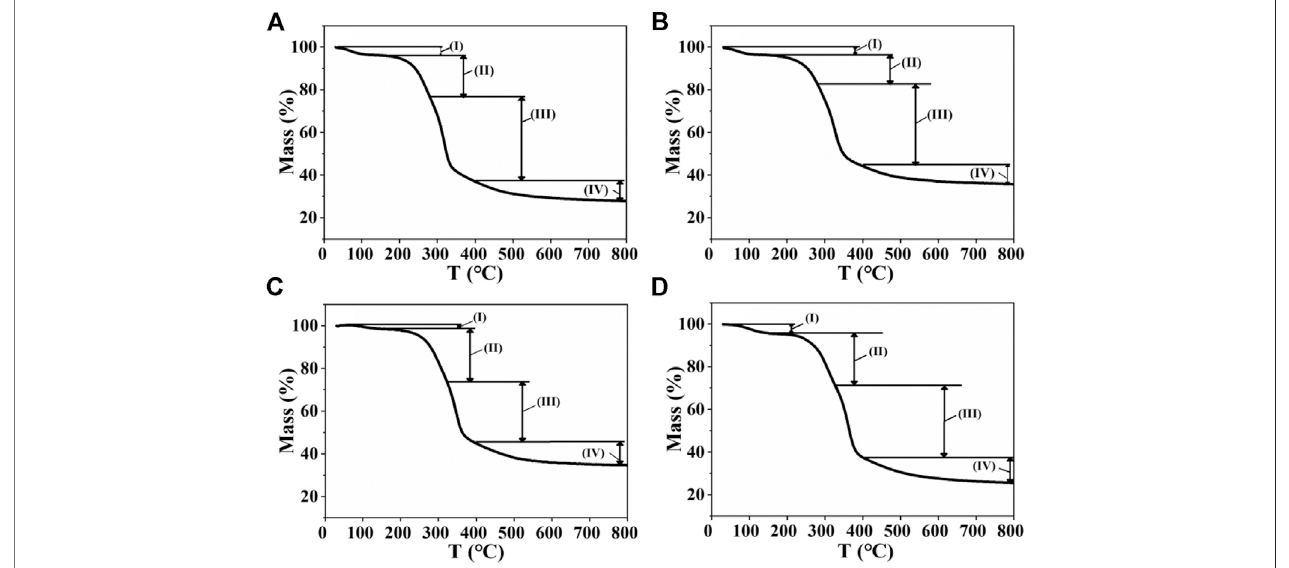
FIGURE 2 | Thermogravimetric curves at different heating rates of (A) 5 ° C/min, (B) 10 ° C/min, (C) 30 ° C/min, and (D) 50 ° C/min.